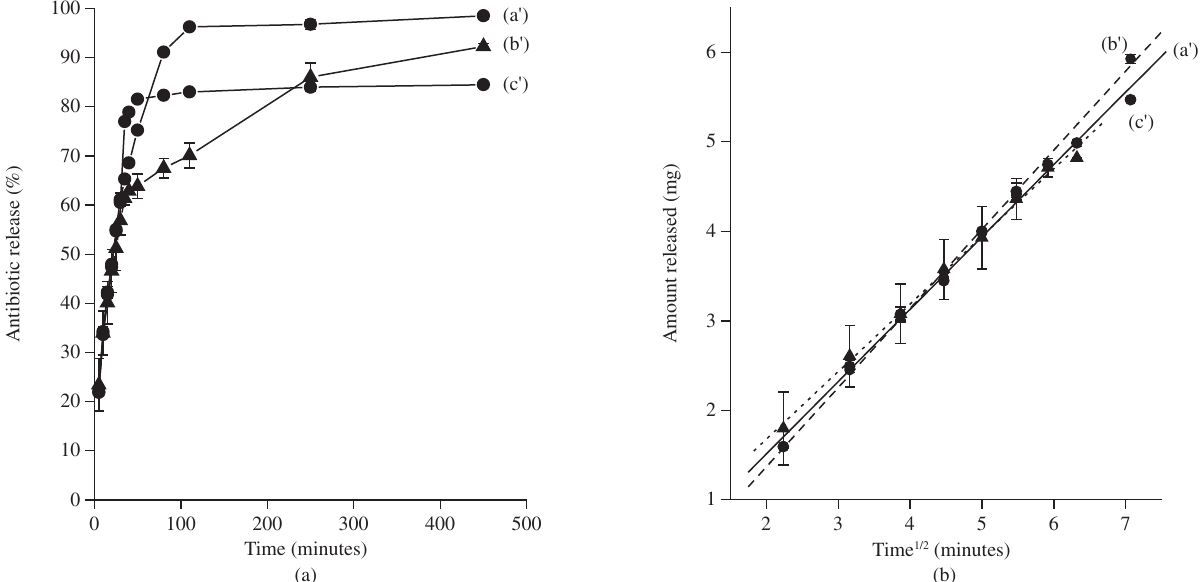
Figure 1. a) Antibiotic release and the b) Higuchi plot determined in anionic collagen membranes: for tetracycline (a’) and rolitetracycline (b’) from membranes cast at pH 3.5 and for tetracycline from membranes cast at pH 7.4